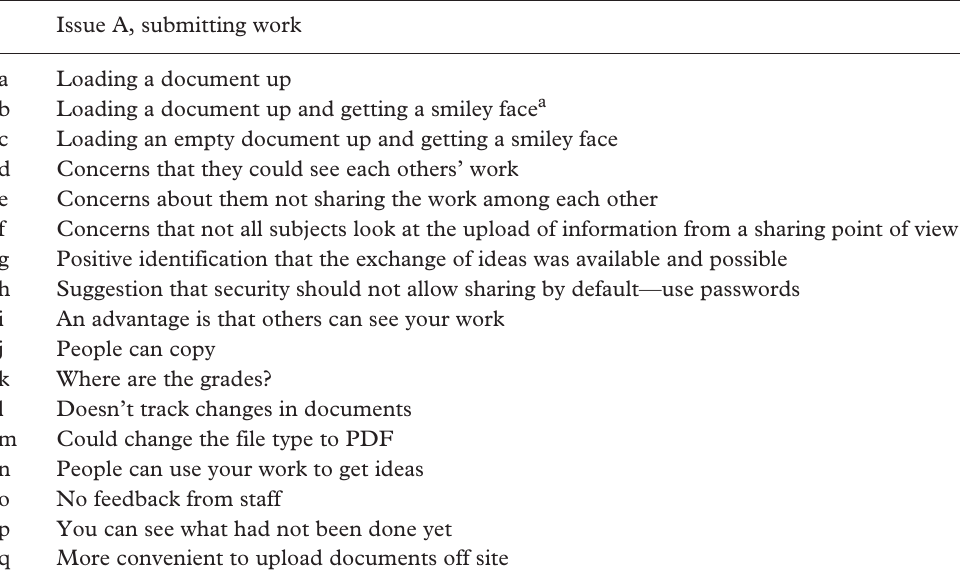
Table 1. Issue 1: submitting work—separate comments, in order of first